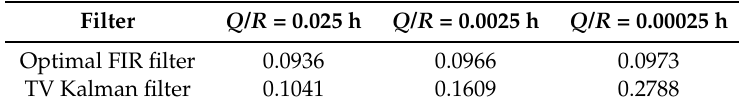
Table 3. The rms estimation errors with various Q / R .